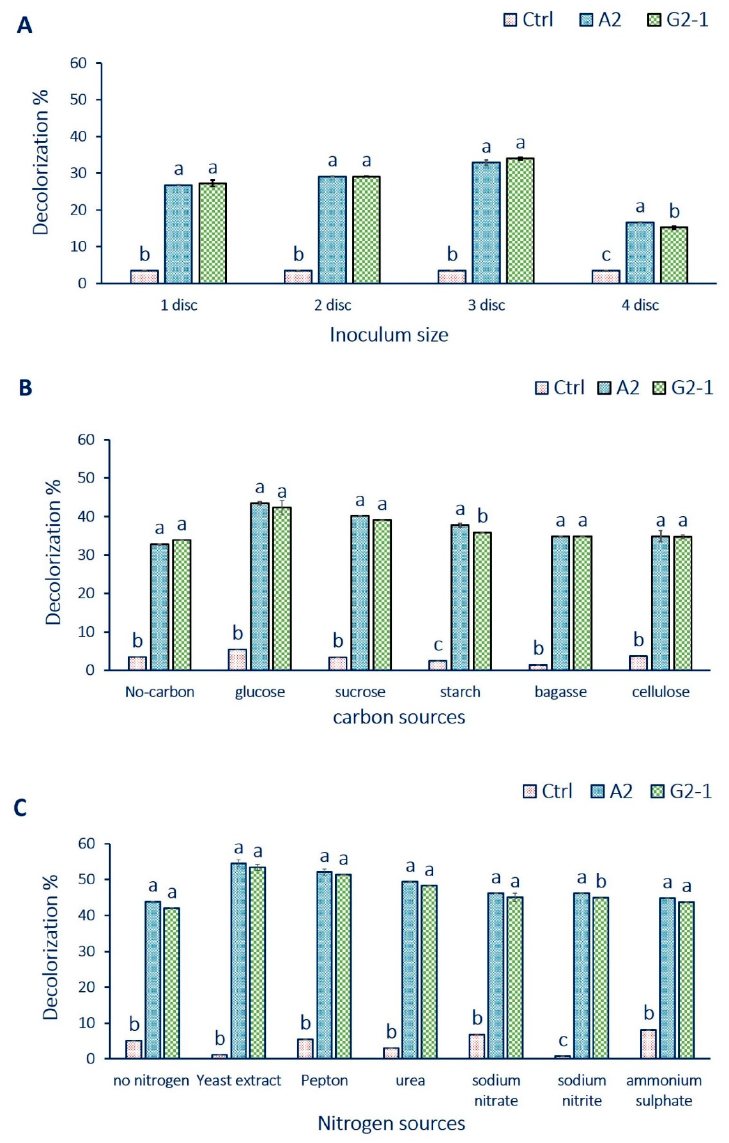
Figure 3. The optimization process of decolorization of crude textile wastewater using fungal strains. ( A ) denotes the effect of different inoculum sizes; ( B ) denotes the effect of different carbon sources; ( C ) the effect of different nitrogen sources. No carbon or no nitrogen denotes inoculated media without adding external carbon or nitrogen source Error bars are Mean ± SE ( n = 3). Ctrl, control without fungal inoculation; A. flavus (A2) and F. oxysporum (G2-1). Different letters on bars denote that mean values are significantly different ( p ≤ 0.05) by the Tukey test.